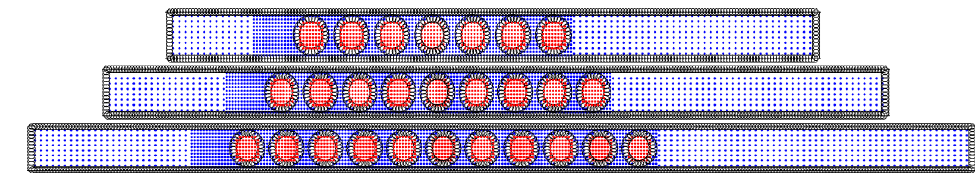
Figure 10. Nodes distribution for 7-column, 9-column, and 11-column finite periodic structures.